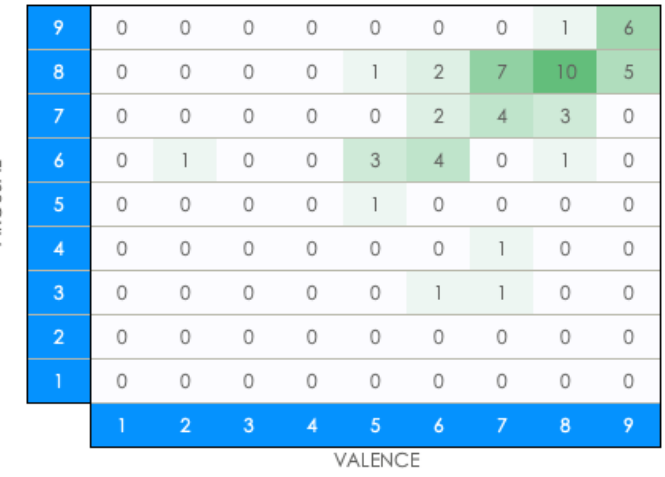
Figure 9. Moods while playing.